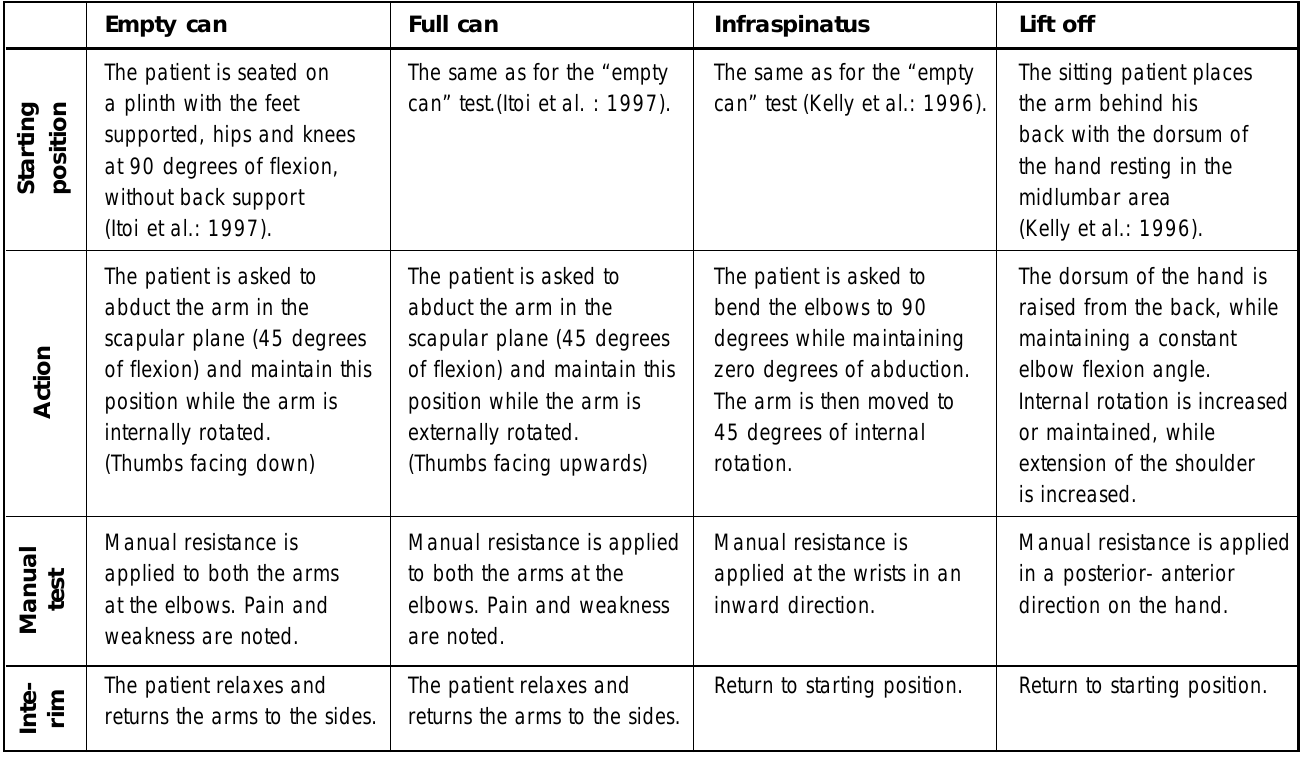
Table 4: Protocol for evaluation of rotator cuff muscle